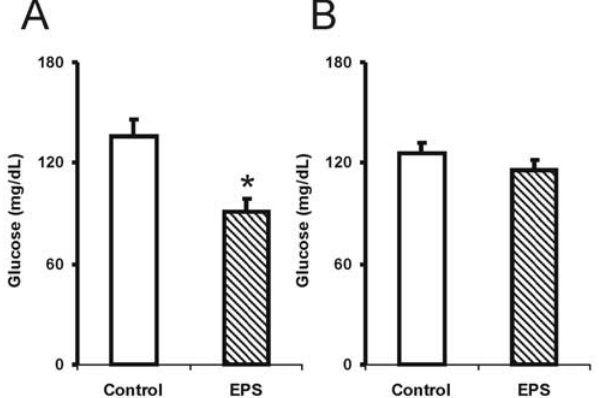
Figure 1. Levels of blood glucose in mice exposed to sub-chronic treatment with lasiodiplodan. ( A ) male and ( B ) female groups. ( * ) Values based on p <